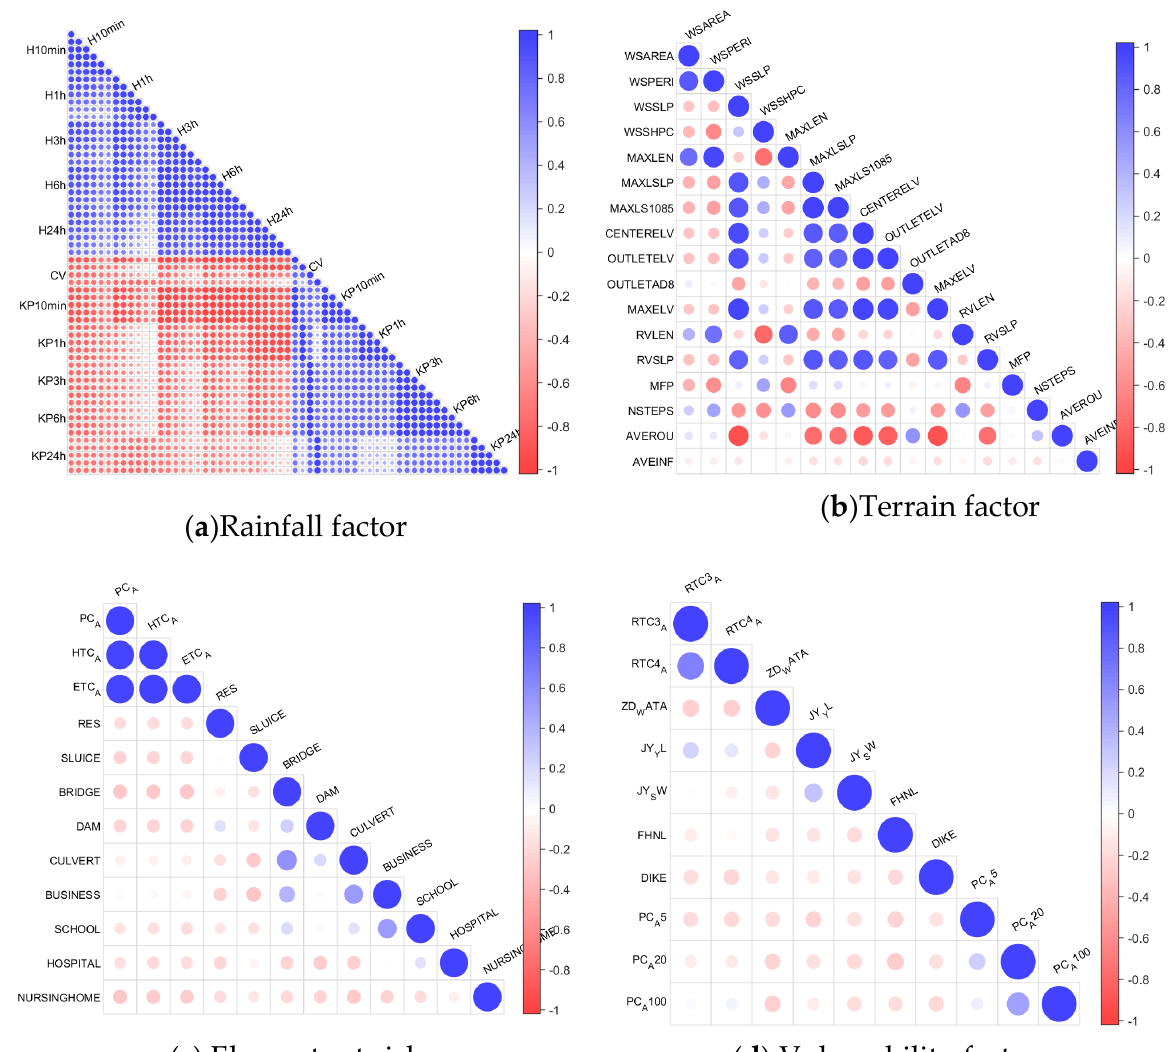
Figure 8. Pearson Correlation Coefficient Matrix.